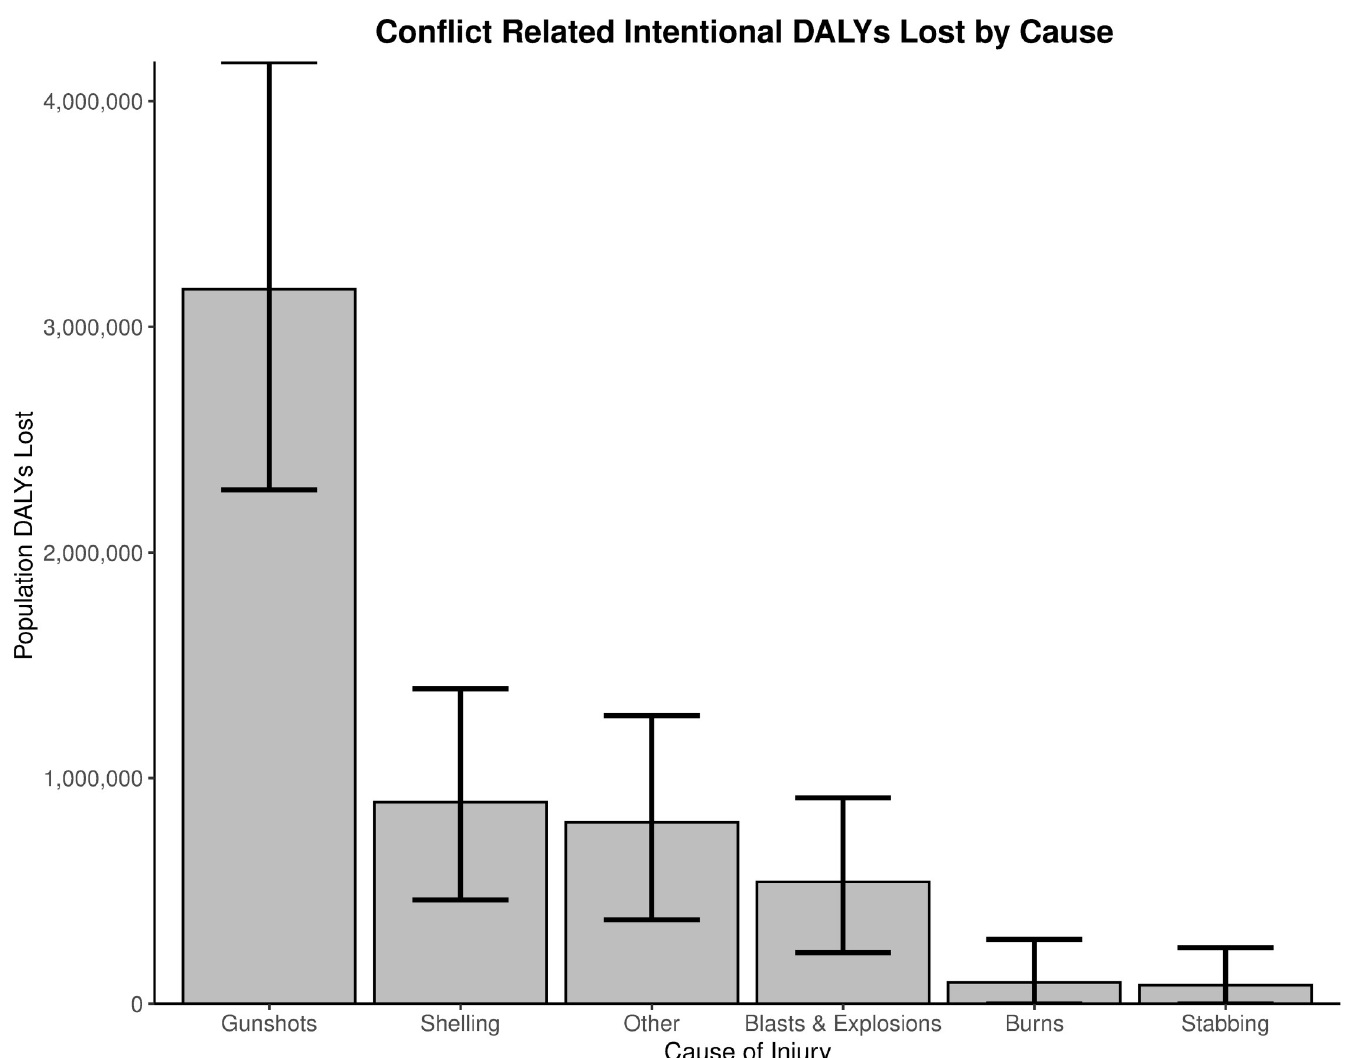
Fig 3. DALYs lost to each identified cause of intentional injury in Baghdad, Iraq, 2003–2014. Source of data: survey of 900 Baghdad residents in May and June 2014, regarding household injury events between 2003 and 2014. DALY, disability-adjusted life